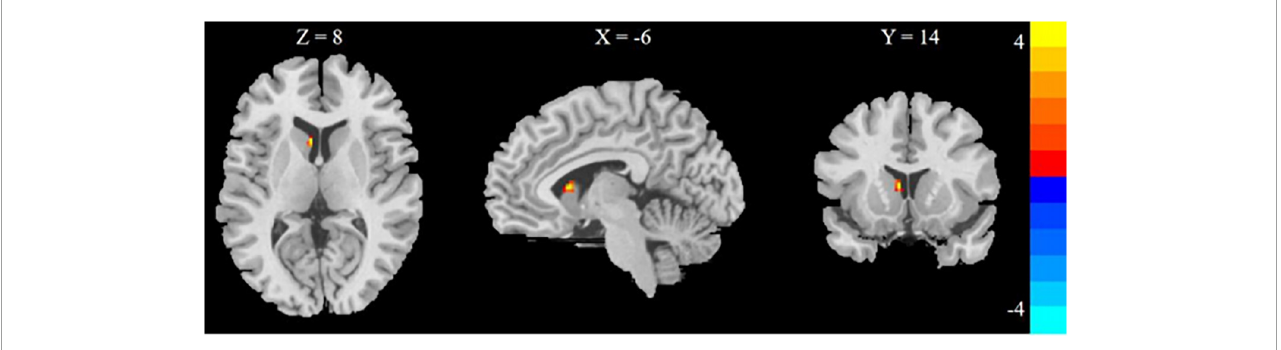
FIGURE4 Regions with different brain regions with voxel-wise group comparison of cerebral blood flow in the HD + HDF group compared to HD group (cluster-level P < 0.05, voxel-level P < 0.001, GRF correction). Color bar indicates t scores. x, y, z = coordinates in Montreal Neurological Institute space. HD, hemodialysis; HDF, hemodiafiltration.